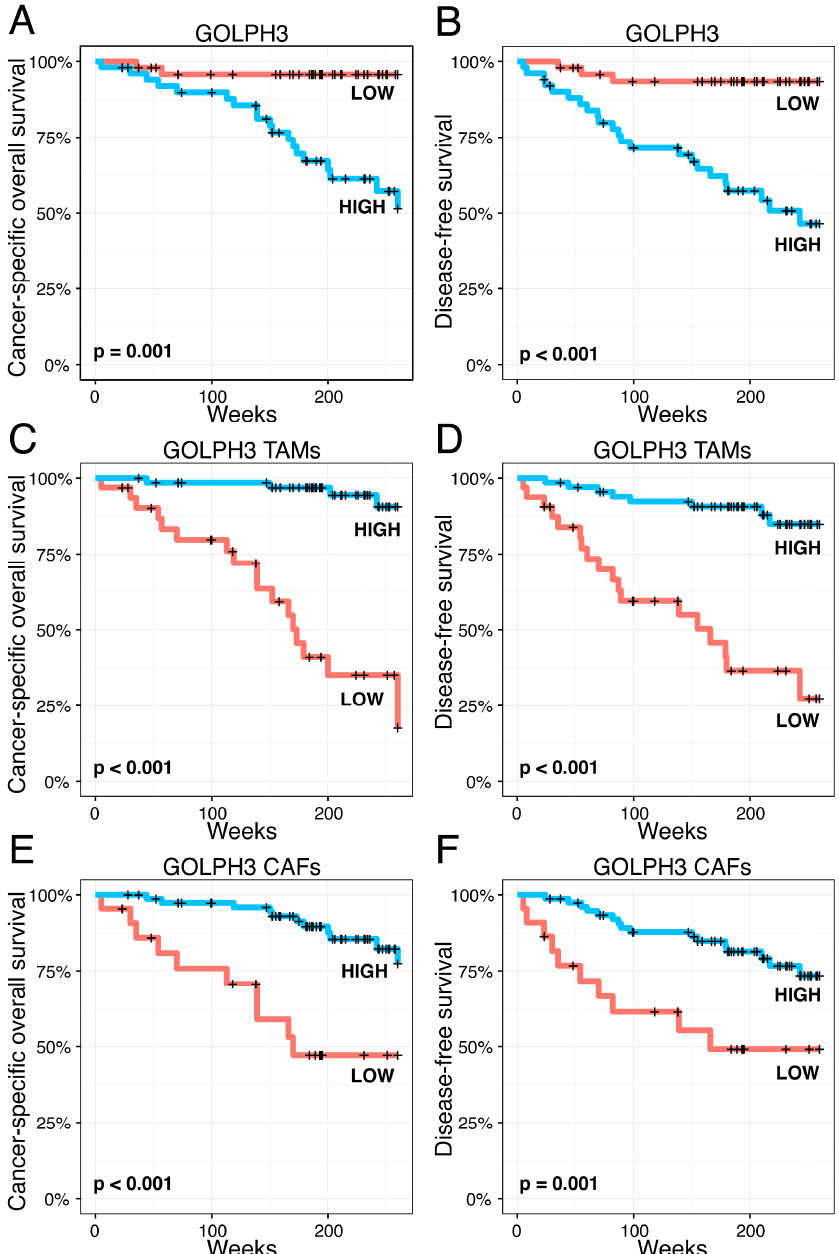
Figure 5. Kaplan-Meier analysis of the prognostic impact of GOLPH3 expression in cutaneous melanoma patients. Upregulation of GOLPH3 in melanoma cells was significantly associated with shorter cancer-specific overall survival (CSOS) and disease-free survival (DFS) ( A and B , respectively). Interestingly, elevated numbers of GOLPH3-positive tumor-associated macrophages and fibroblasts demonstrated contrary prognostic significance and were correlated with significantly longer CSOS and DFS (respectively, C and E for CSOS, D and F for DFS).